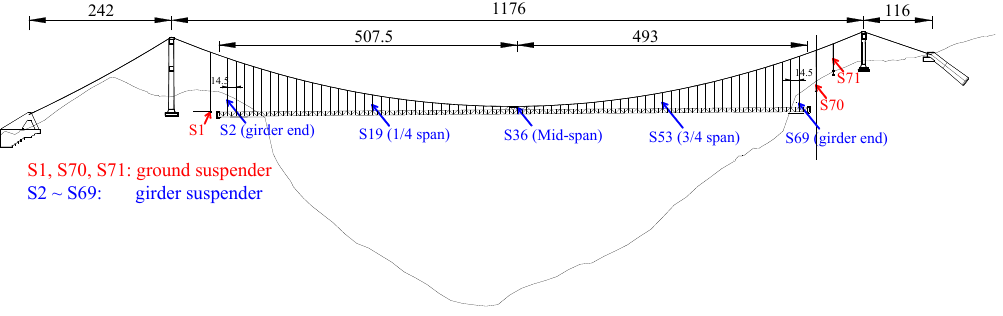
Figure 6. Layout of the prototype suspension bridge (m).